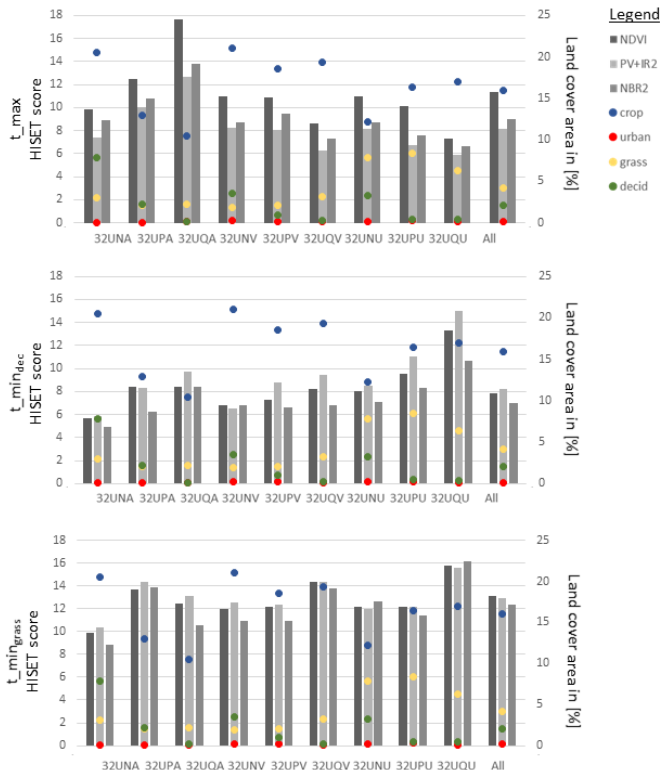
Figure A1. Performance of the thresholds t _ max , t _ min dec and t _ min grass derived from three spectral indices (NDVI, PV+IR2, NBR2) to separate between spectrally similar LC types measured by the HISET score for each S2 tile separately and for all tiles together. The lower the HISET score, the better the separability between the respective LC